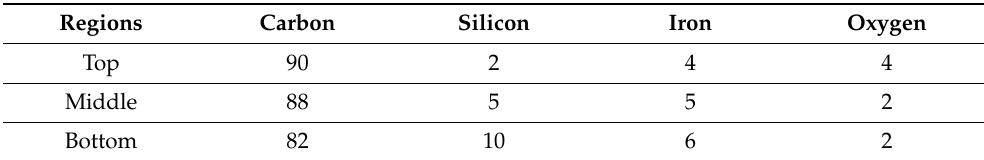
Figure 6. SEM image of MWCNTs obtained in secondary electron registration mode ( a ) and combined secondary electron/backscattering electron registration mode ( b ). SEM image of the array showing the areas of analysis and images of catalytic nanoparticles (red colored) ( c ). EDX-derived Fe/C ratio obtained using EDX analysis along the height of the MWCNT array ( d ). Table 1. Content (at.%) of main elements in various regions of the MWCNT array (Figure 6c) determined by EDX spectroscopy.